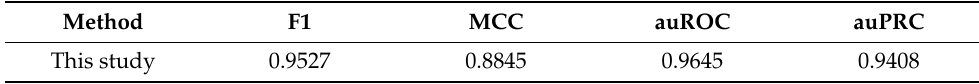
Table 5. Test results on the combined VFDB and toxinpred2 dataset.